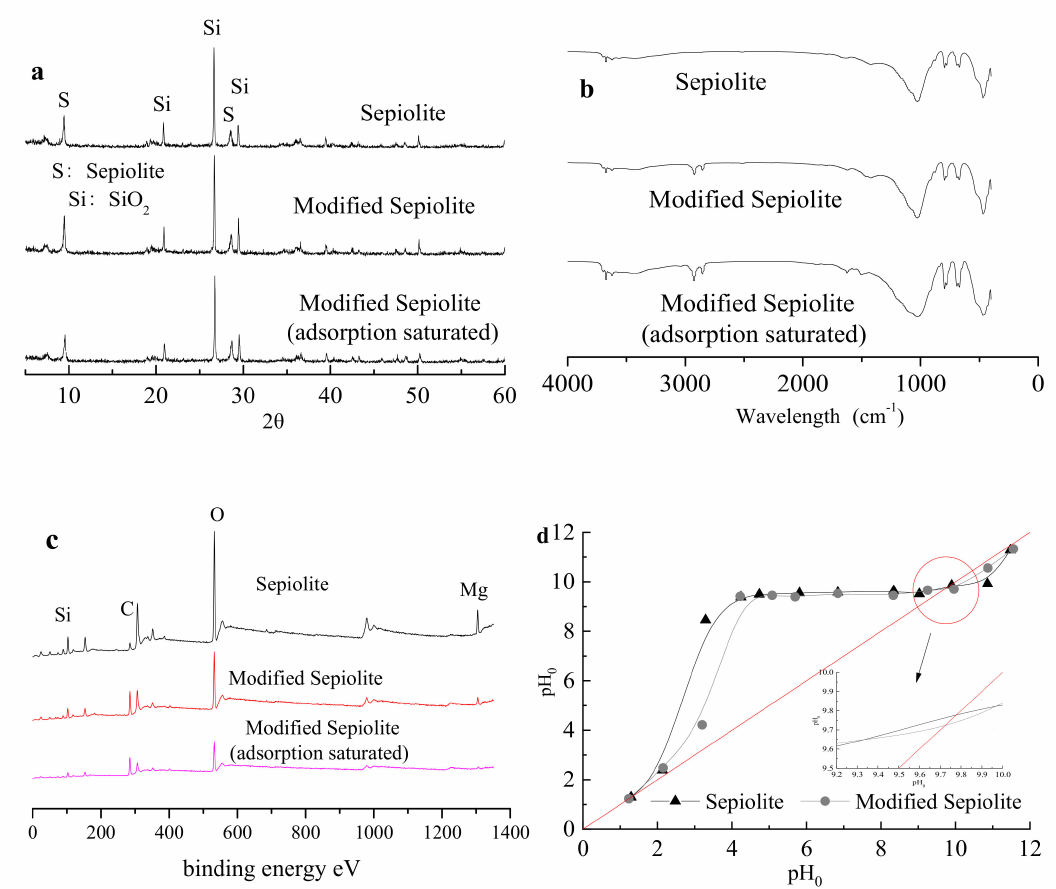
Figure 2. ( a ) X-ray di ff raction spectrum of original sepiolite, modified sepiolite and modified sepiolite after adsorption saturated; ( b ) Fourier-transform infrared spectrum of original sepiolite, modified sepiolite and modified sepiolite after adsorption saturated; ( c ) X-ray photoelectron spectrum of original sepiolite, modified sepiolite and modified sepiolite after adsorption saturated; ( d ) Isoelectric point of original sepiolite and modified